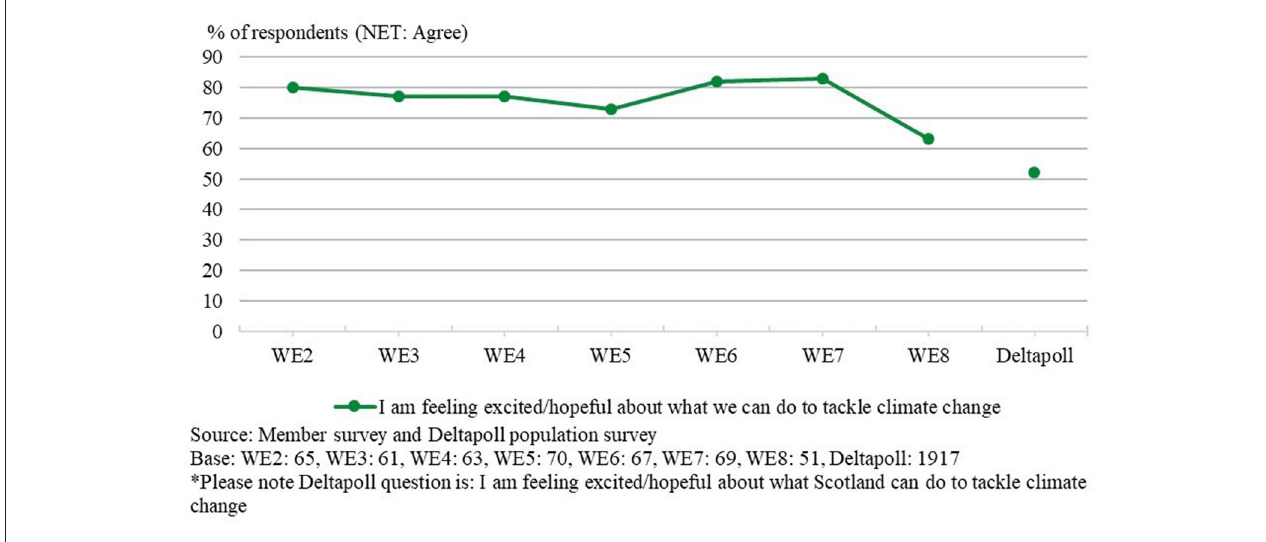
FIGURE 1 | Assembly members and public feelings of excitement and hopefulness.